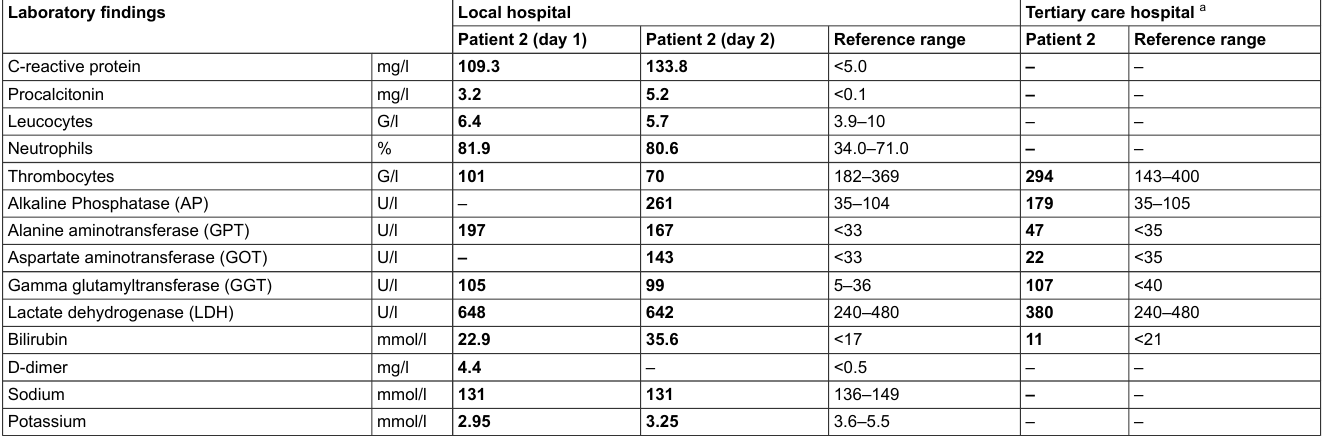
Table 3: Patient 2: Blood chemistry results at the local and tertiary hospital (final diagnosis: pneumonia due to Chlamydia abortus). Laboratory findings